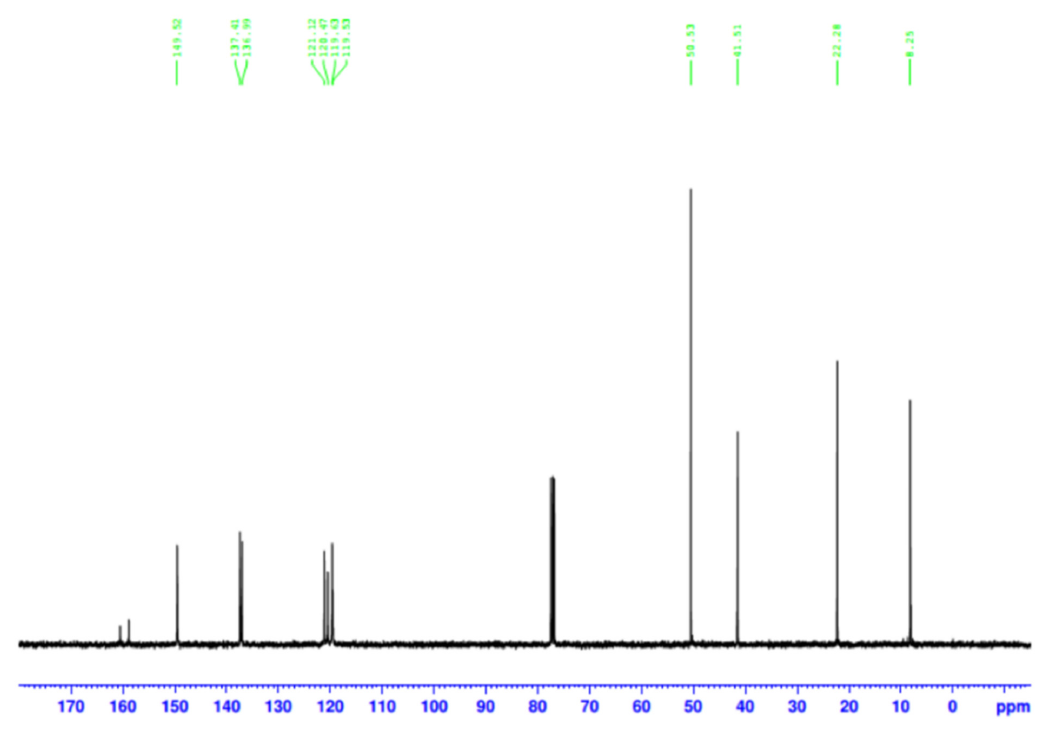
Figure A1: 13 C NMR spectrum of MPTES-SS-Py in dideuteromethylenechloride